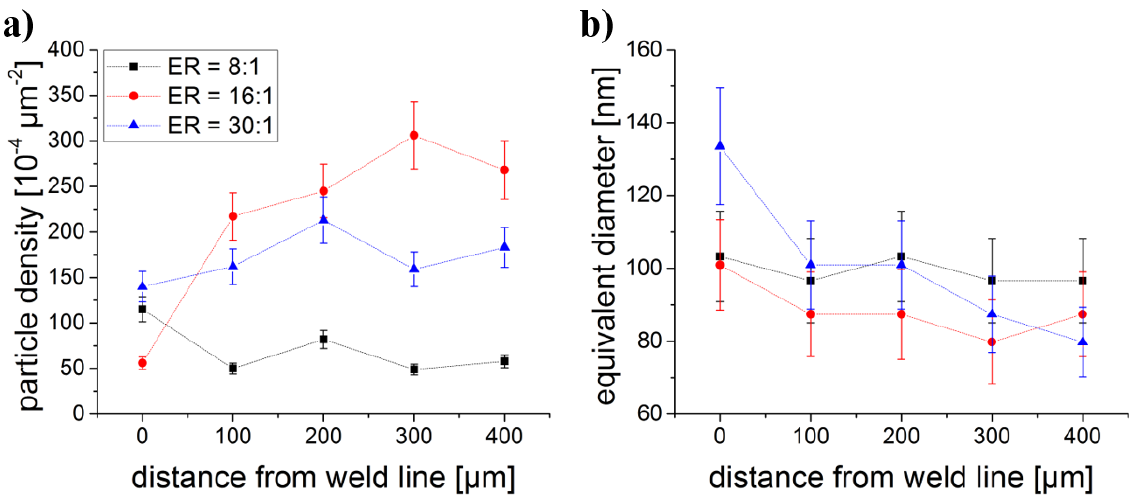
Figure 13. Particle density ( a ) and size ( b ) in the weld seam as a function of the distance from the weld line.